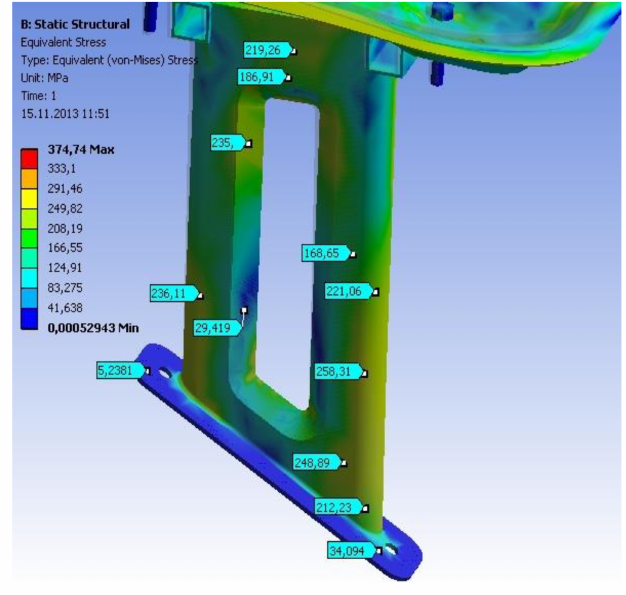
Figure 8. Strength map of the